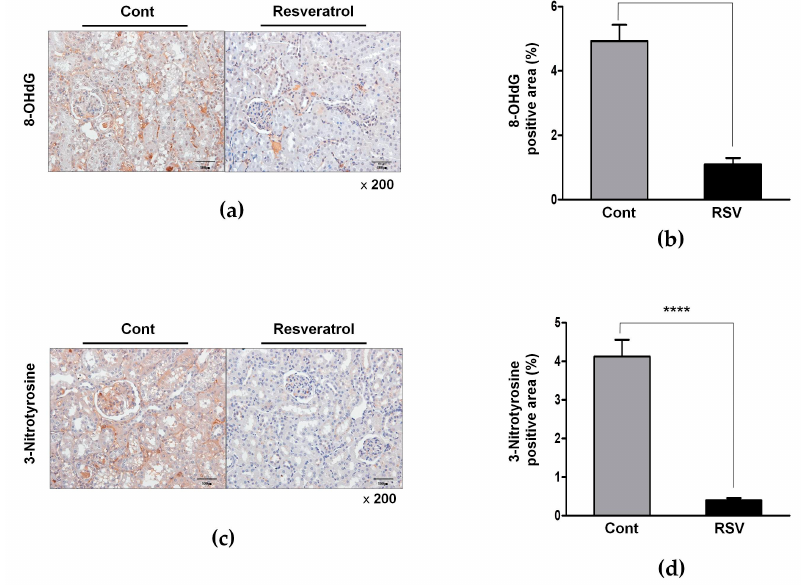
Figure 10. Effects of resveratrol on renal oxidative stress. ( a ) Representative images of immunohistochemistry for 8-OHdG in aging kidney glomerulus (original magnification 200 × ). ( b ) The positive area expression of 8-OHdG in the renal tissue was decreased in the RSV group, compared to that in the Cont. group. ( c ) Representative images of immunohistochemistry for 3-Nitrotyrosine in the aging kidney glomerulus (original magnification 200 × ). ( d ) The positive area expression of